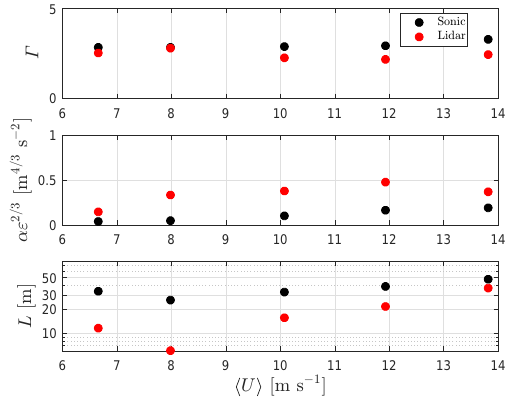
Figure 20. Mann parameters for a number of wind-speed ranges (see Table 1) derived from sonic anemometer and lidar radial veloc- ity